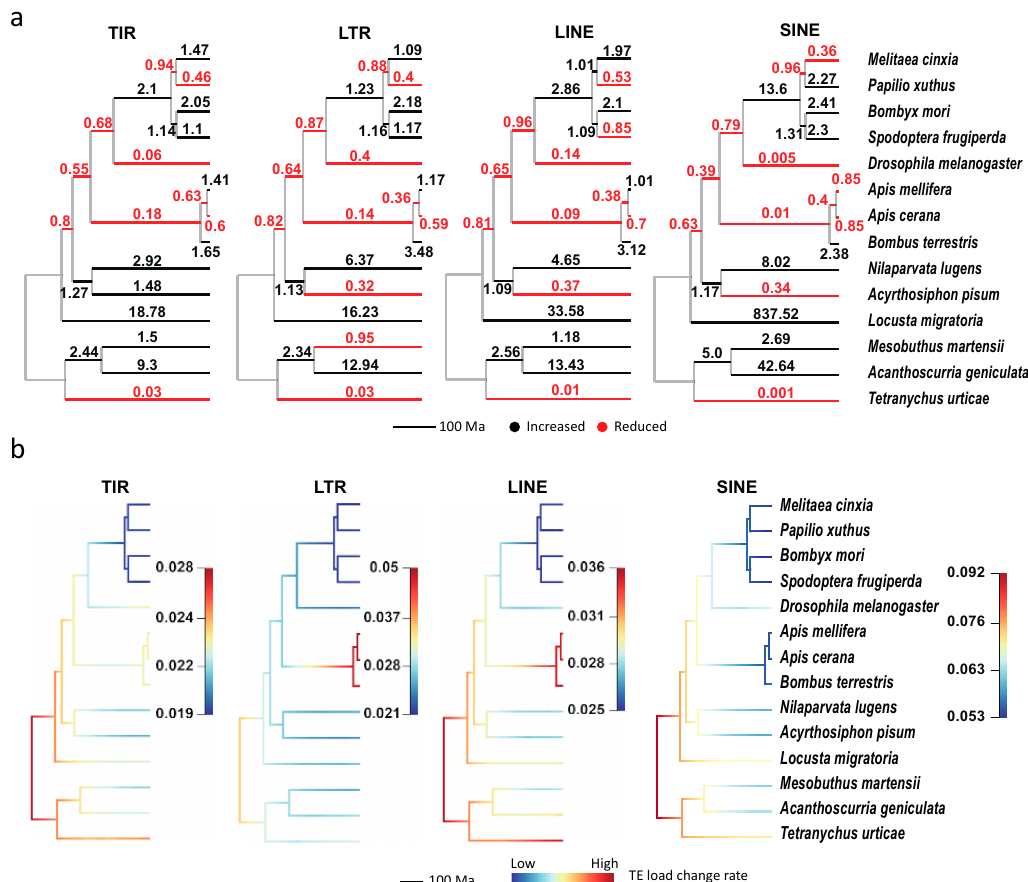
Figure 6. The expansion and contraction of TEs in the 14 arthropod species. ( a ) The ratio of TE load change (the offspring relative to the ancestral node) for each branch. ( b ) The dynamic evolutionary rates of TE loads in the phylogeny. Branch colors are scaled by evolutionary rates of TE loads, and rate increases from the cold color (blue) to warm color (red). TIR, terminal inverted repeat; LTR, long terminal repeat; LINE, long interspersed nuclear element; SINE, short interspersed nuclear element.